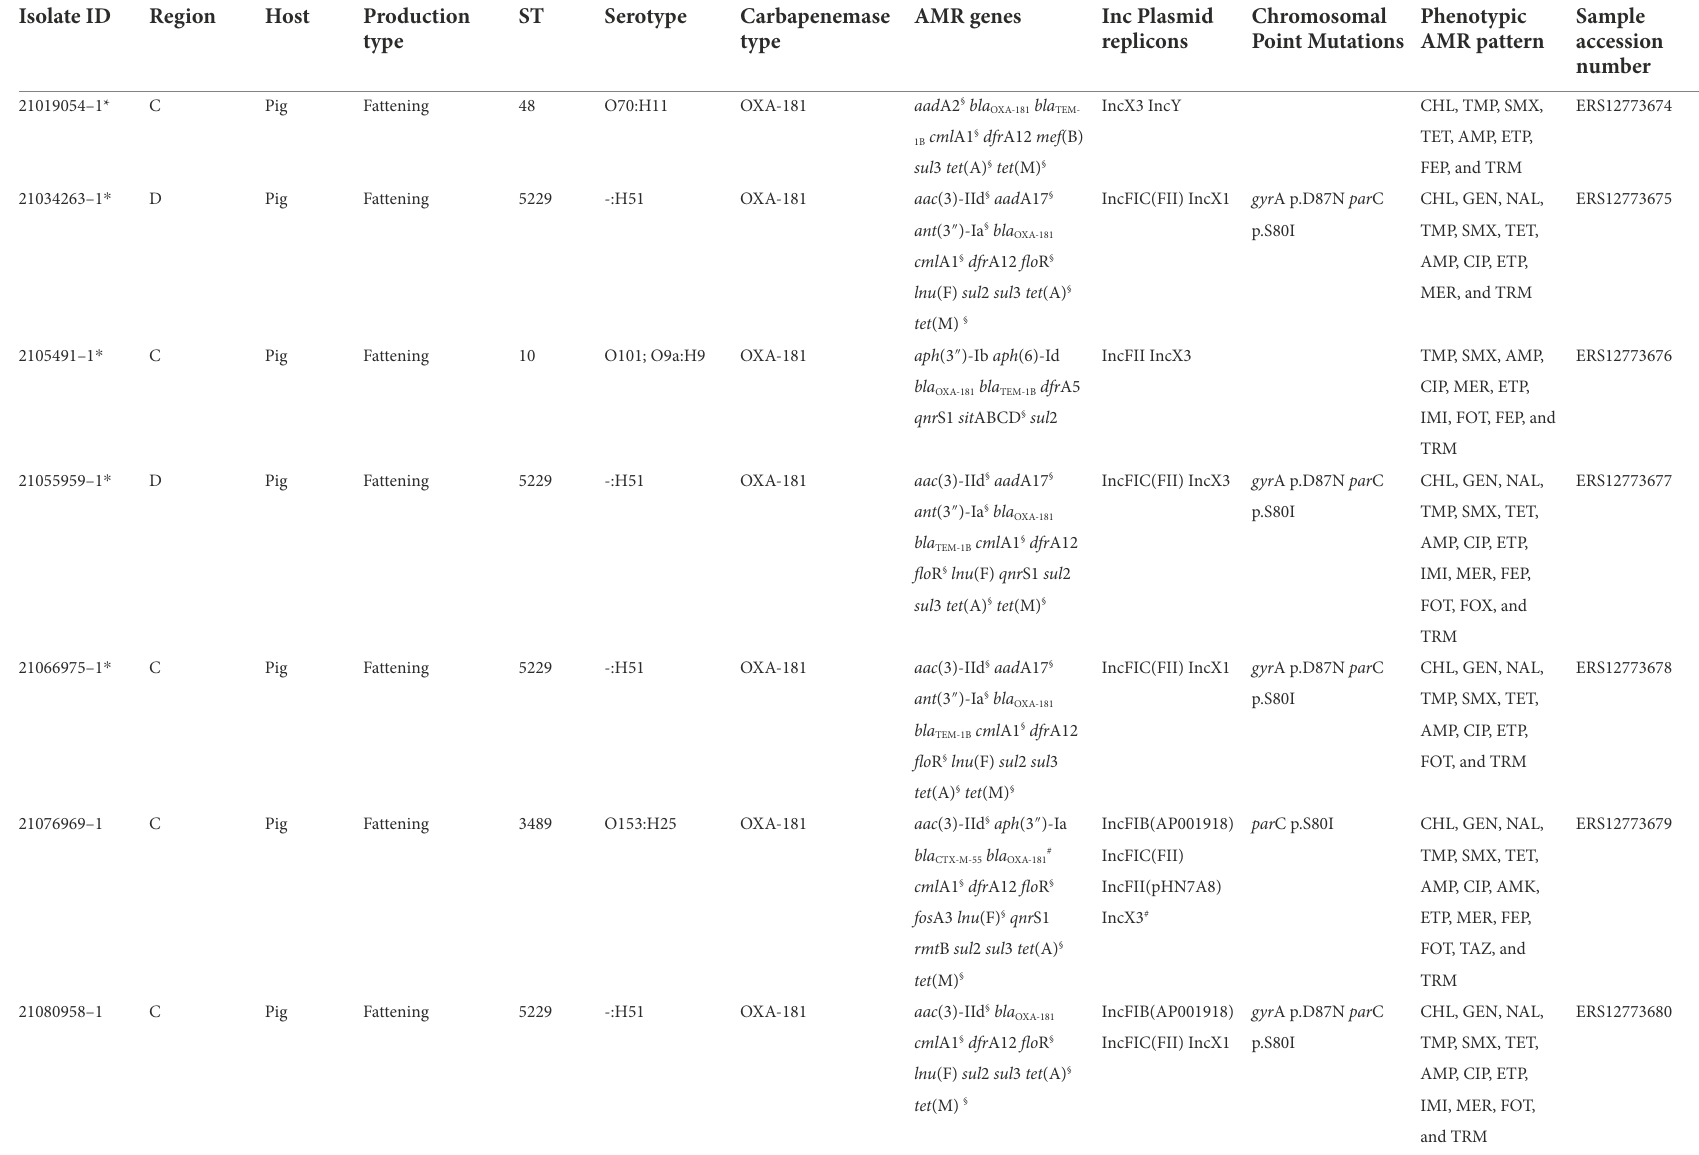
TABLE 2 Metadata and genomic characteristics of the OXA-48(like) producing E. coli obtained from the samples collected from the survey at